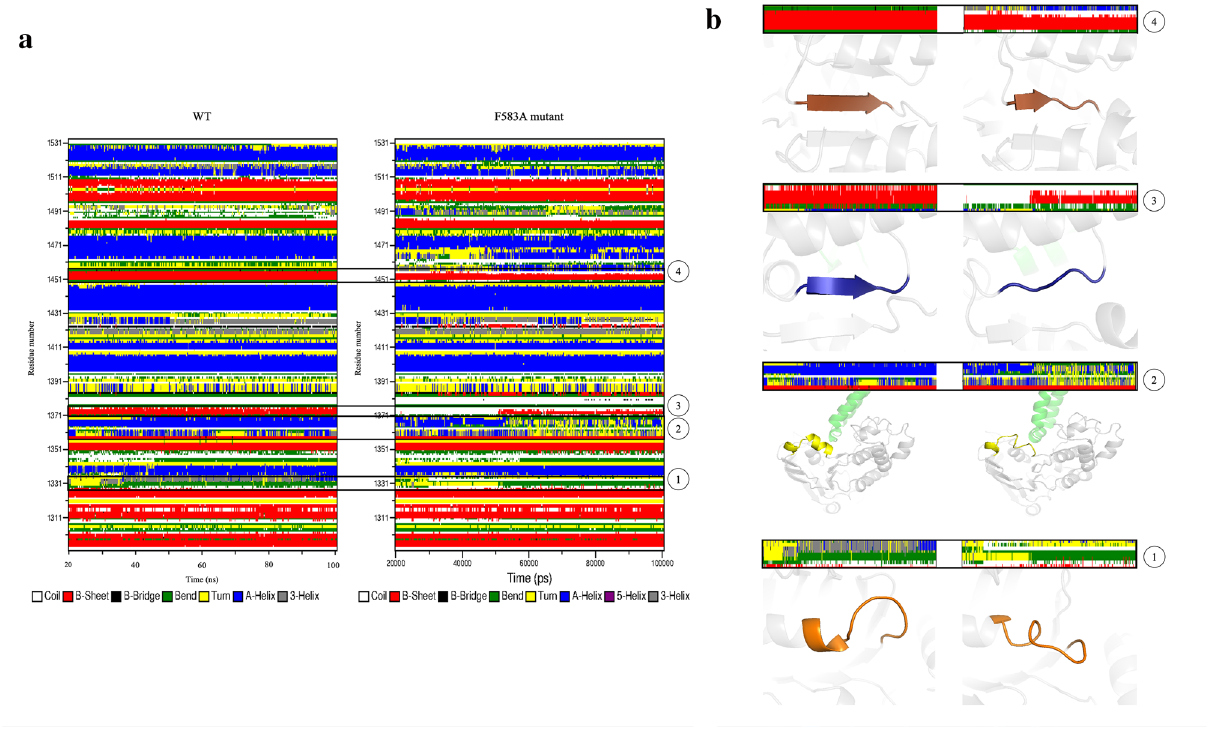
Figure 7. Secondary structure analysis of NBD2 is shown using the STRIDE algorithm. (a) DSSP colored map representing the secondary structure elements of each residue as a function of time. Color code representing the structure is shown beneath the graphs. (b) A zoom in snapshot of four key elements in NBD2 numbered according to their occurrence from N- to C-terminus: (1) Walker A, (2) s5/h2 loop, (3) Q-loop, and (4) Walker